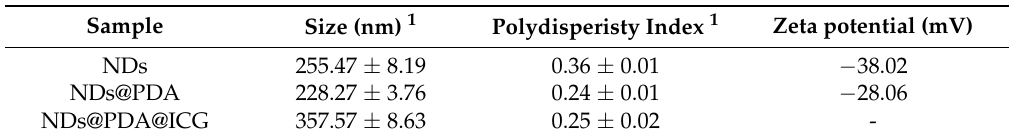
Table 1. Dynamic light scattering measured the hydrodynamic diameter and zeta potential of NDs-based clusters. The error is given as a standard deviation.